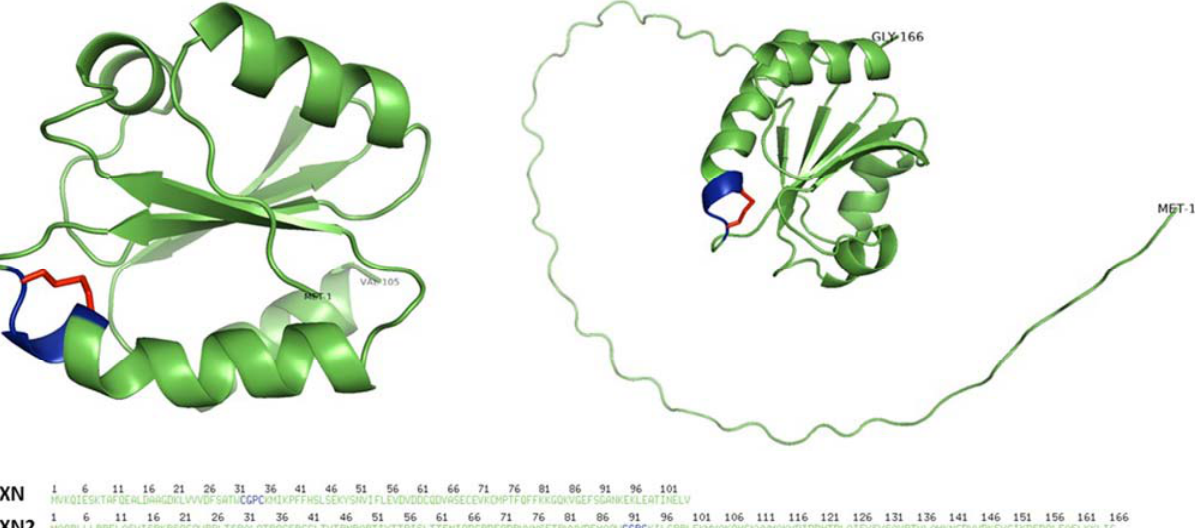
Figure 2. Three-dimensional structure of human thioredoxins. The 3D structure of human cytoplas- mic thioredoxin (TXN) ( left ) and mitochondrial thioredoxin 2 (TXN2) ( right ), in their oxidized forms, are shown (UniProt accession P10599 and Q99757, respectively). The 3D representation includes labeled N- and C-termini and highlights the active site thioredoxin fold in blue and the disulfide bond in red. The structures were generated using PyMOL (http://www.pymol.org/pymol, accessed on 31 March 2023) after retrieving TXN1 and TXN2 protein data bank (PDB) formats from AlphaFold [7,8].